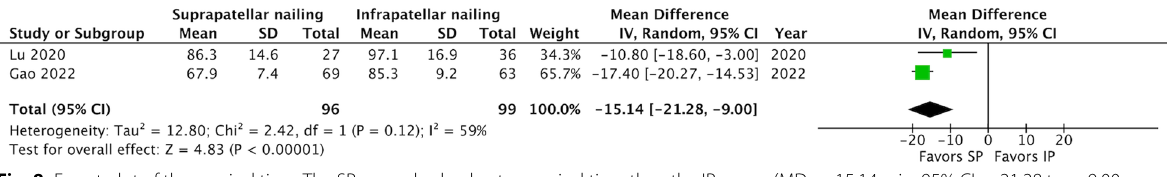
15.14 min; 95% CI 21.28 to 9.00; − − −